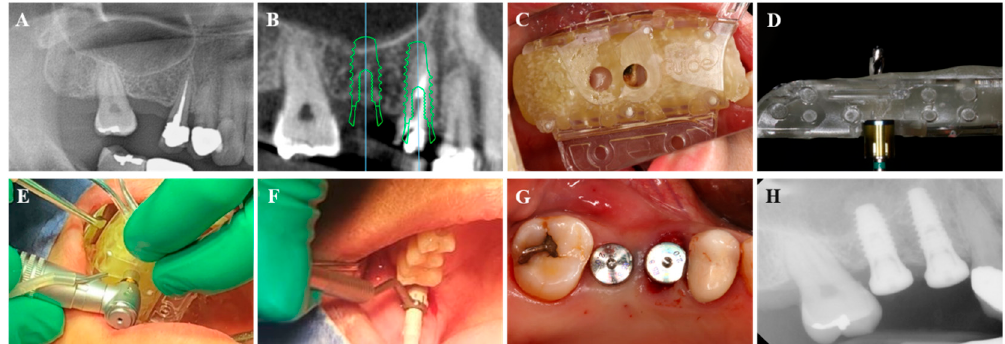
Figure 2. The simultaneous crestal sinus grafting procedure using the VARO guide. ( A ) A section of the pre-surgical panoramic radiograph showing the site of implantation. The upper right second premolar was vertically fractured; therefore, an immediate implant was planned. ( B ) Virtual planning of implants on upper right second premolar and molar regions on CBCT imaging. ( C ) The fabricated VARO guide was seated in the mouth after the extraction of the upper right second premolar. ( D ) The Sinus Drill with a stopper of the correct length was used for the initial entry into the maxillary sinus. ( E ) Sequential osteotomy was performed using the VARO guide. ( F ) A hydraulic tube was utilized for the elevation of the Schneiderian membrane. ( G ) Tissue-level implants were placed. ( H ) A periapical radiograph showing the typical “dome-shape” elevation following the crestal sinus graft.